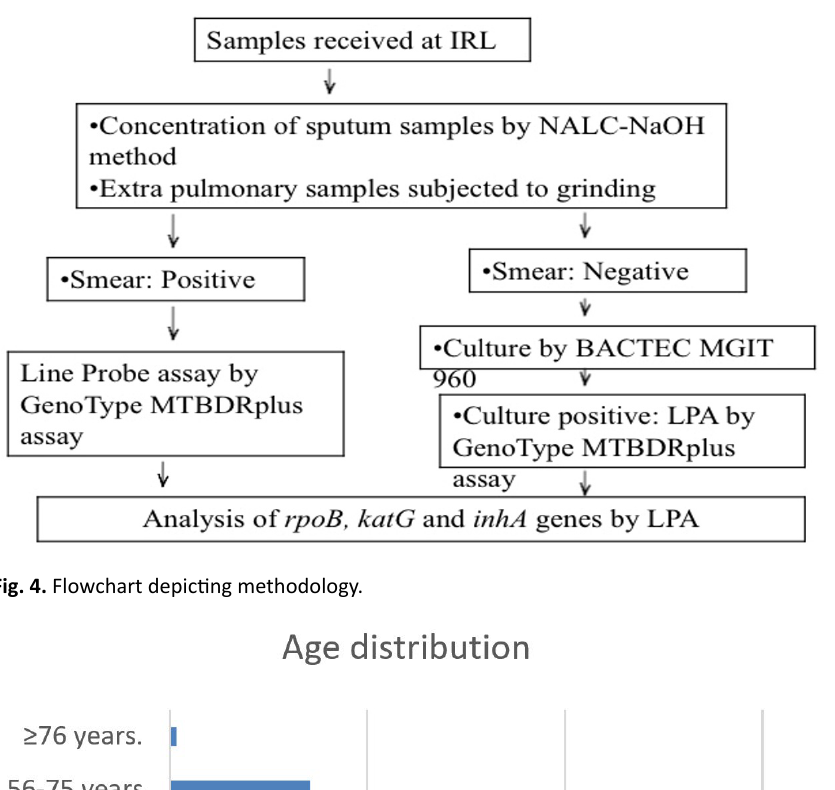
Fig. 4. Flowchart depicting methodology.